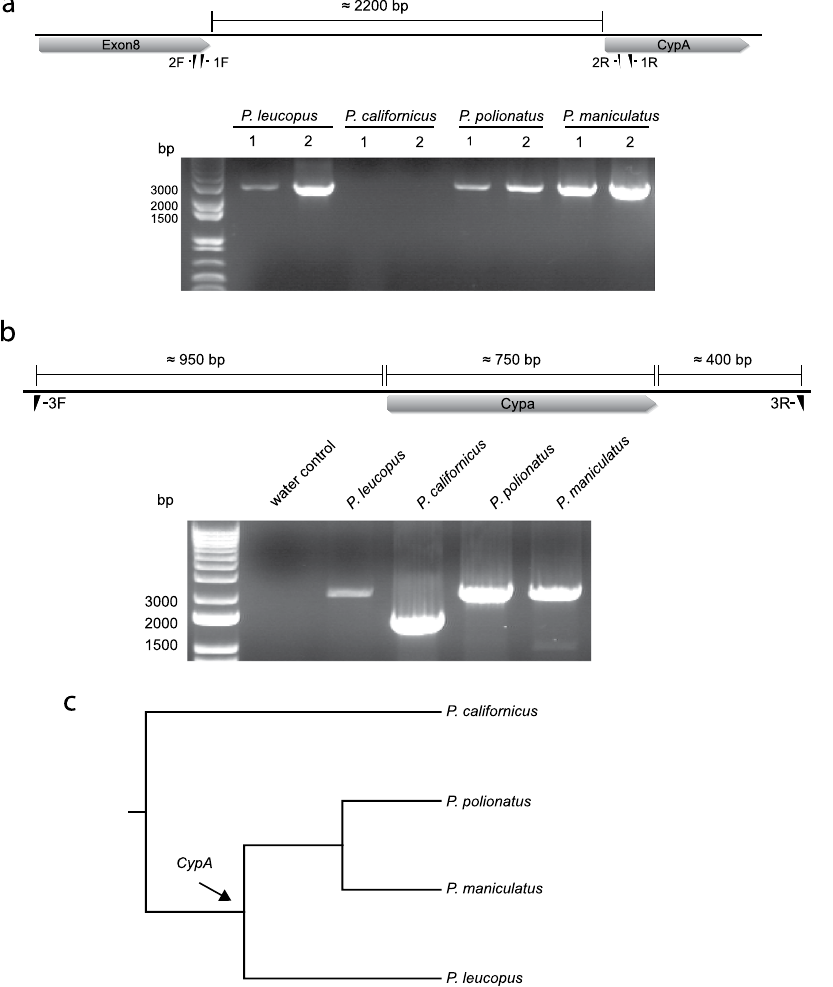
Figure 6. Evolution of TrimCyp in the genus Peromyscus . ( a ) Upper panel shows the schematic of the region containing the exon8 of Trim30d of P. maniculatus and CypA . Figure was created using Geneious 43 . Primers used in the PCR are denoted. (Lower panel) PCR products were generated using the genomic DNA of the indicated Peromyscus genus species with the primer sets 1 or 2 shown in the upper panel. Gel picture is representative of 2 independent experiments. For the uncropped version of the gel picture see Supplementary Fig. 7A. ( b ) Upper panel shows the schematic of the genomic region surrounding the CypA in the Trim5 cluster of P. maniculatus . Figure was created using Geneious 43 . Primers used in the PCR are denoted. Approximate length of each of the indicated regions is shown above the figure. (Lower panel) Agarose gel showing the PCR products that were amplified using the genomic DNA of the indicated Peromyscus genus species with the primers in the upper panel. Gel picture is representative of 2 independent experiments. For the uncropped version of the gel picture see Supplementary Fig. 7B. ( c ) Cladogram depicting the evolutionary relationship between the Peromyscus genus species tested for CypA presence. Arrow indicates the suggested insertion point of the CypA gene in the Trim5 locus. The species tree was generated with TimeTree 45